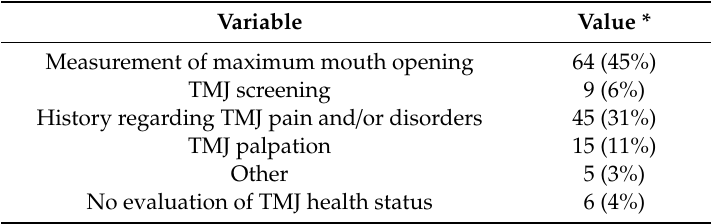
Table 2. Typical procedures included in the evaluation of the temporomandibular joint (TMJ) prior to